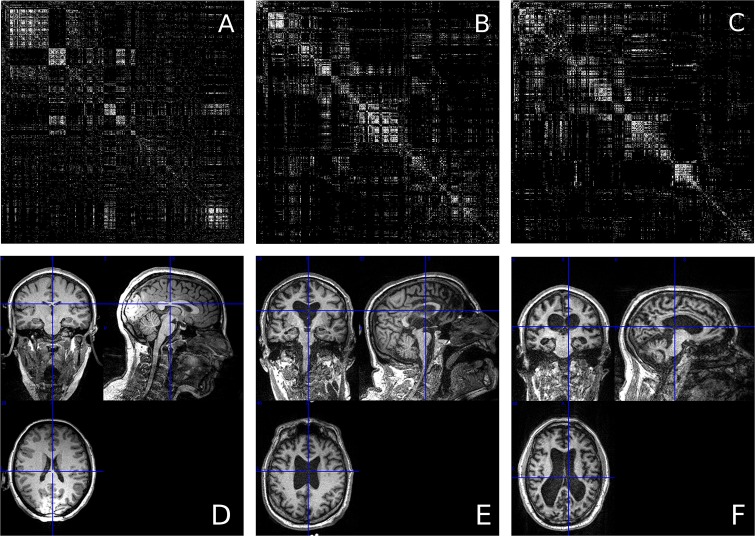
Adjacency matrices by condition.Three 1000 × 1000 adjacency matrices, representing the three conditions. A is a sample from the healthy control group, B is a sample from the MCS group, and C is a sample from the VS group, It is not immediately apparent that the fractal dimension of points in these groups is different. Below, see the associated structural scans (D is from a healthy control volunteer, E is from an MCS patient, and F from a VS patient). Note the increasingly cortical atrophy and expansion of ventricles as severity increases. Structural scans visualized in MRICron http://people.cas.sc.edu/rorden/mricron/index.html.